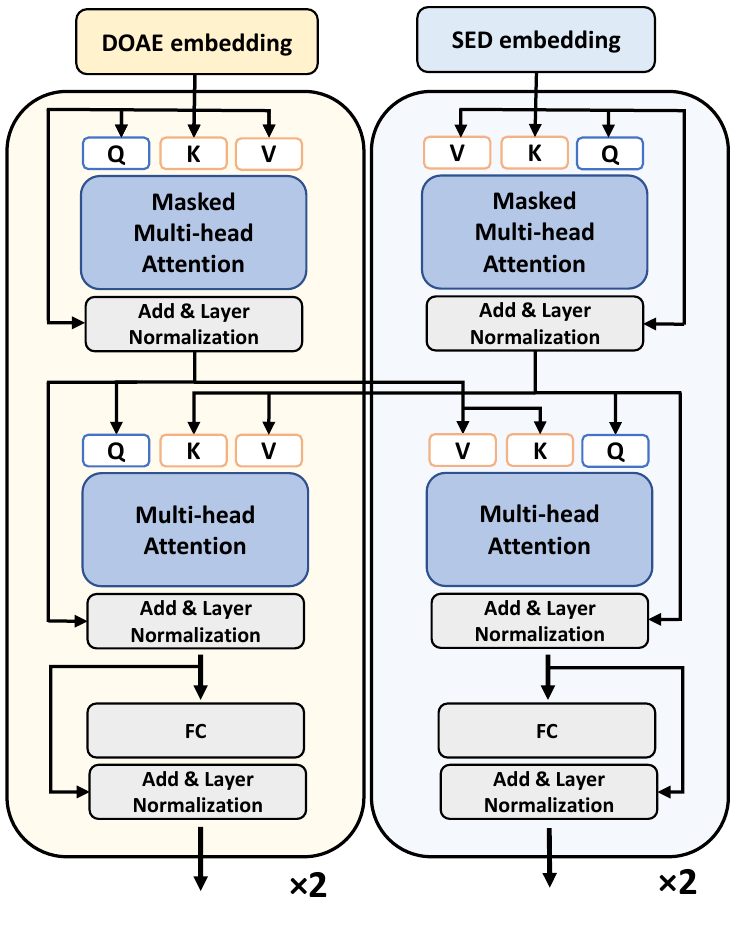
Figure 1. The schematic diagram of the decoder. Q, K, and V indicate the query, key, and value in the attention,